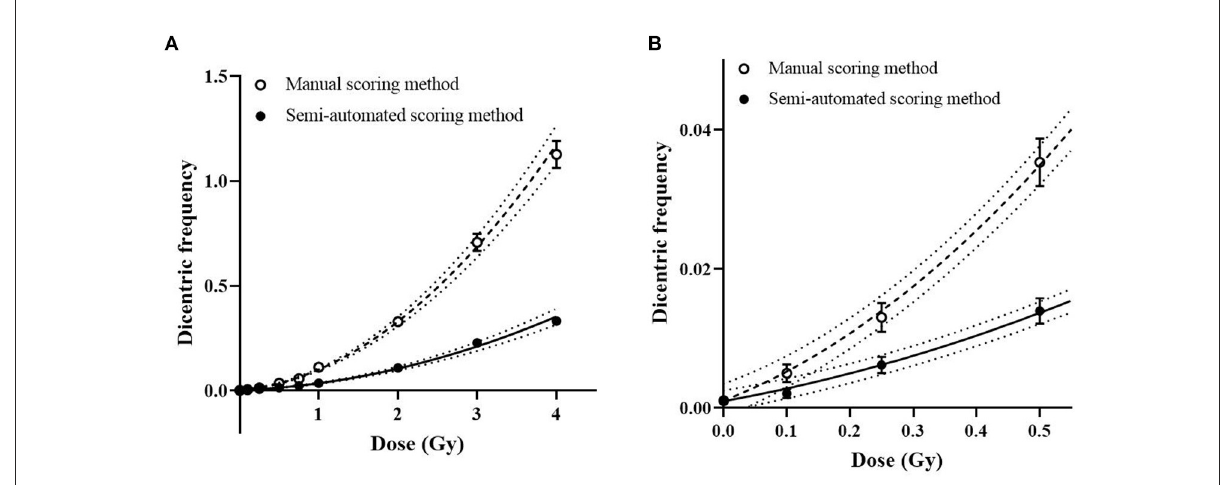
FIGURE1 Dose response curve for dicentric chromosome assay (DCA). Symbols and bars represent averaged dicentric yields and standard error by manual (open circles) and semi-automated scoring (filled circles) methods. (A) Dose response curves by manual (dashed curve) and semi-automated scoring (straight curve) methods and their 95% confidence intervals (dotted curves) are represented. (B) A magnified curve of low-dose region ( < 0.5Gy) is shown.